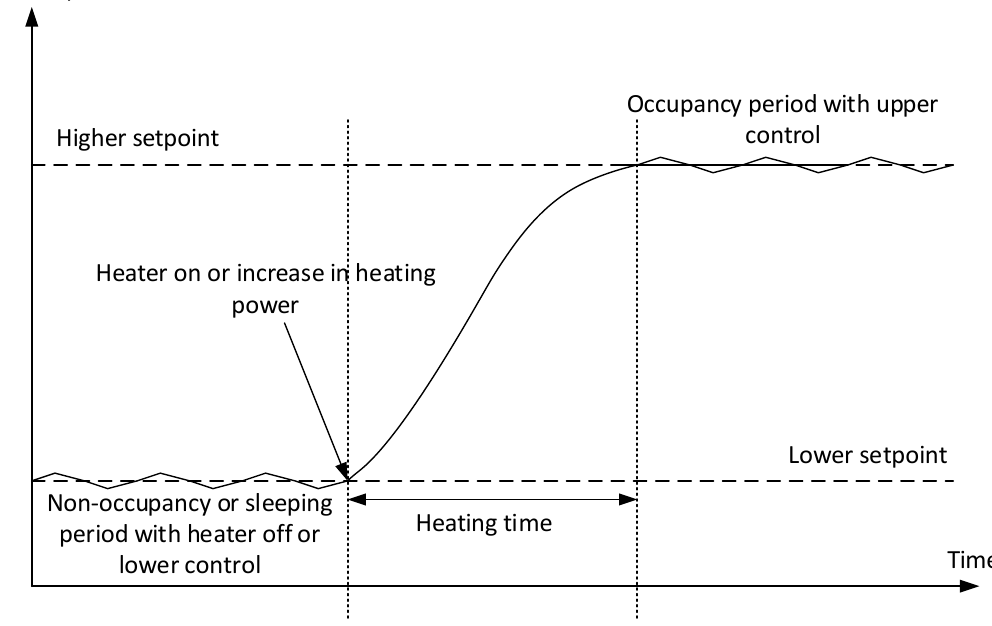
Figure 1. The temperature change during the heating of a building when the occupancy is